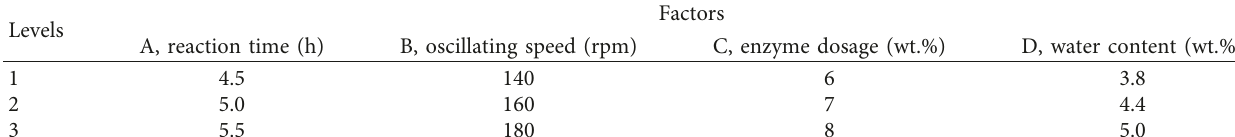
Table 1: Factors and levels for orthogonal test.